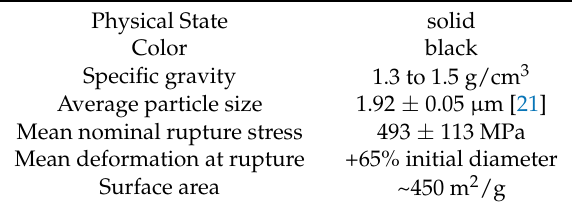
Figure 1. Synthesis of poly (1-methylpyrrol-2-ylsquaraine) (PMPS) particles. Table 1. Physical characteristics of poly (1-methylpyrrol-2-ylsquaraine) PMPS particles [18,19].